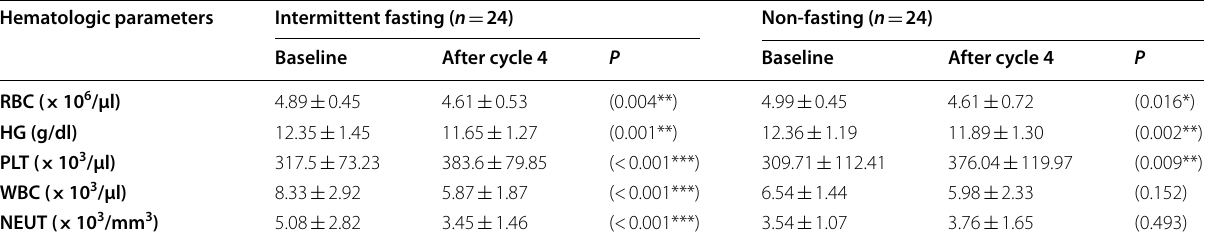
Table 3 Comparison between the two studied periods according to hematologic parameters in each group